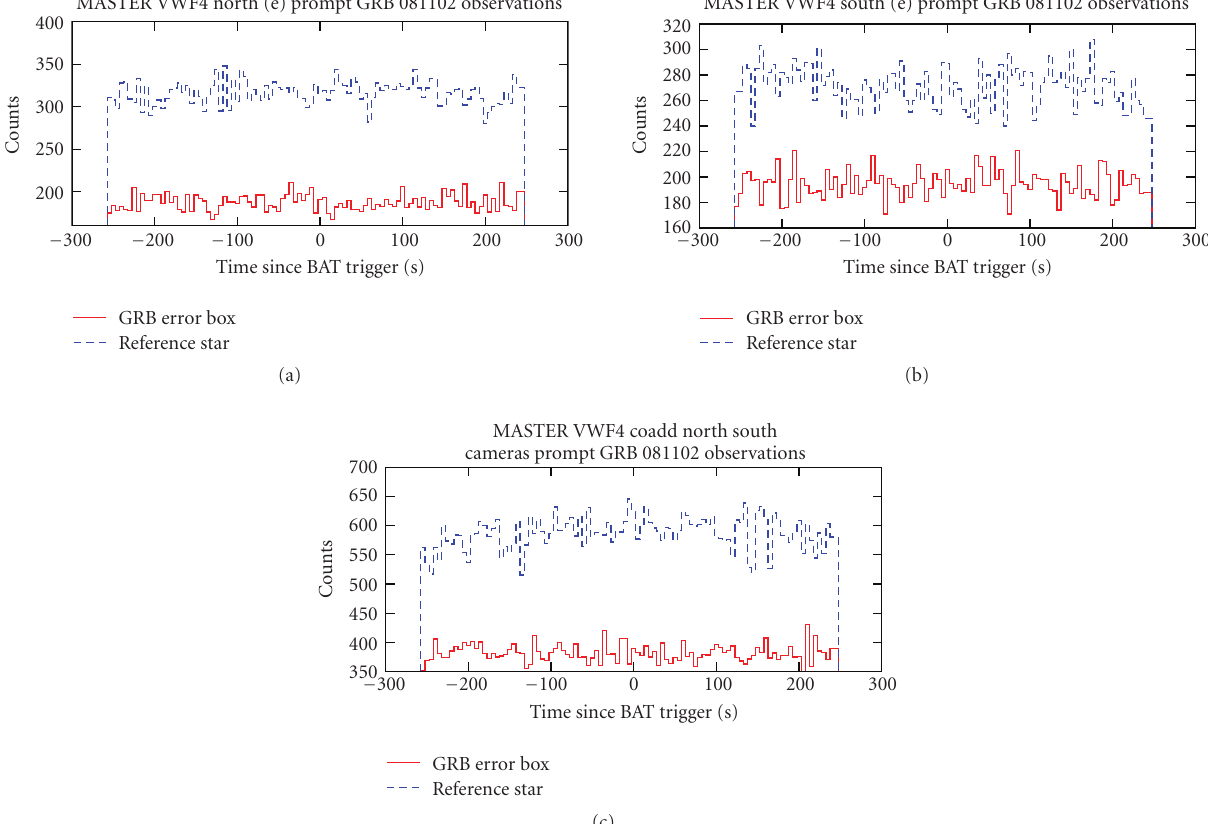
the entire error box at the edge of its field of view.